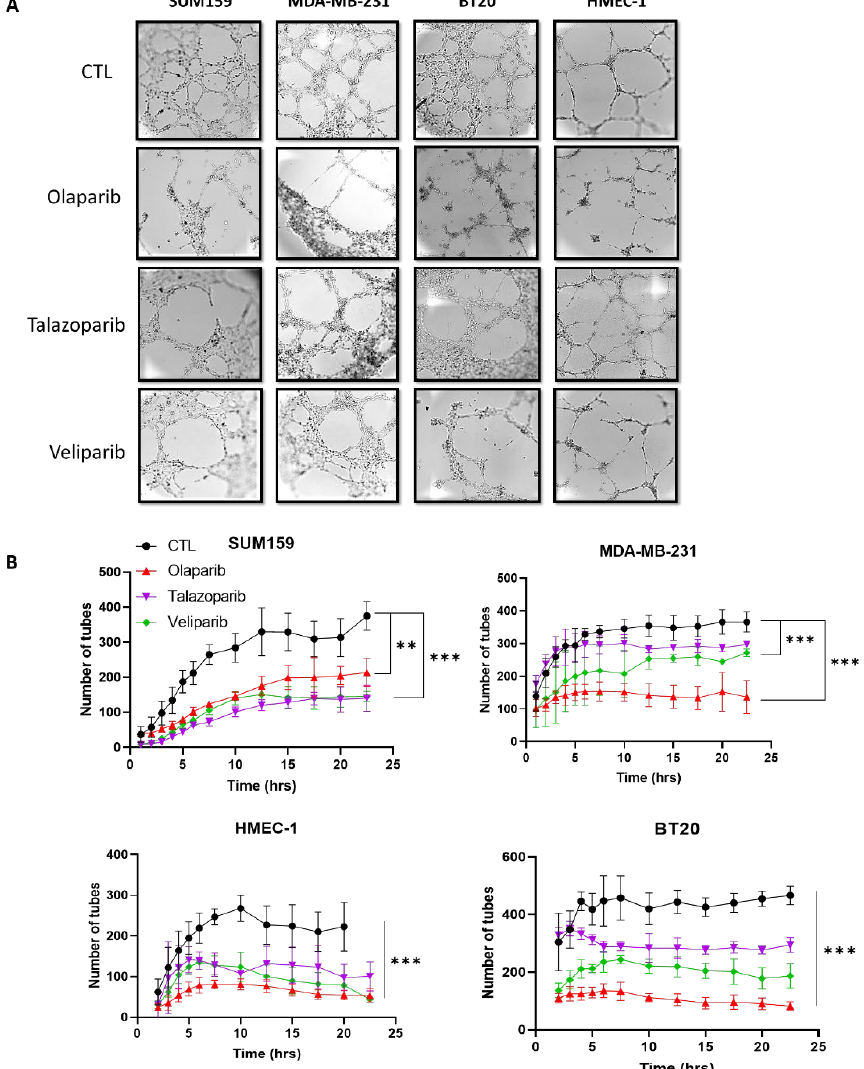
Figure 2. Effect of PARPis on the vascular mimicry. Time-lapse video microscopy experiments were realized on the HMEC-1 endothelial cells, and the breast cancer MDA-MB-231, SUM159, and BT20 cells treated for 72 h with olaparib (20 µ M), talazoparib (10 nM), and veliparib (20 µ M) before being seeded on Matrigel. ( A ) Representative pictures taken at 24 h. ( B ) Number of tubes formed. Experiments were realized at least three times and the data are expressed as mean ± SEM., ** p < 0.01, *** p < 0.001.